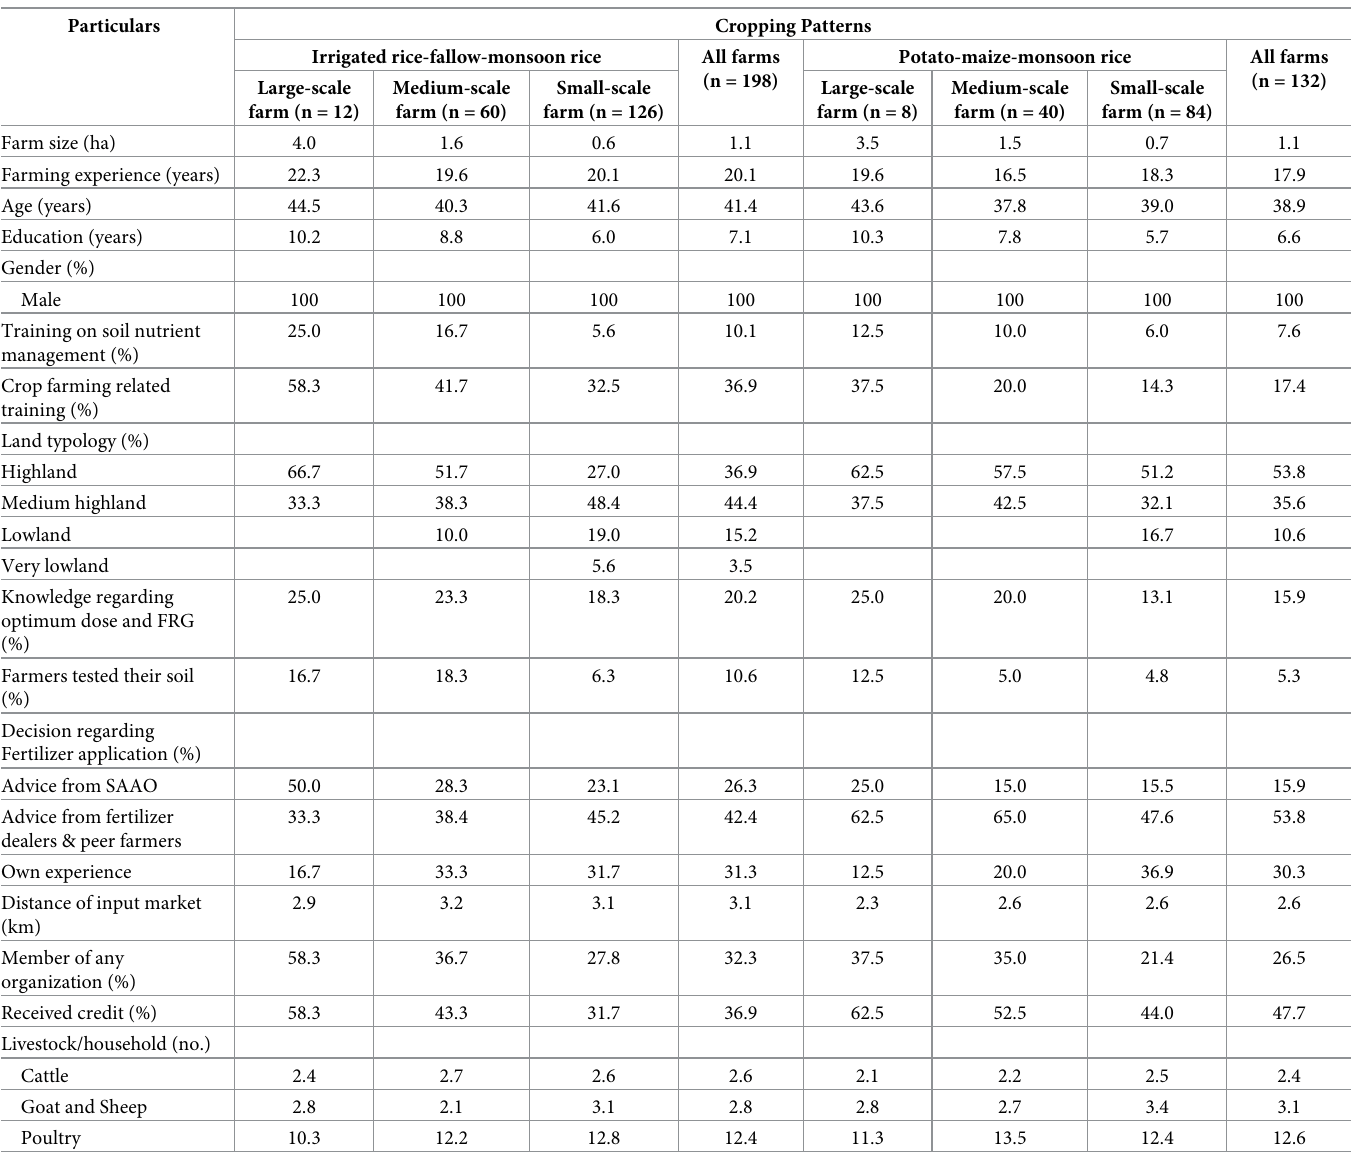
Table 2. Socio-demographic characteristics of the farmers in diverse rice-based cropping patterns in the study areas.